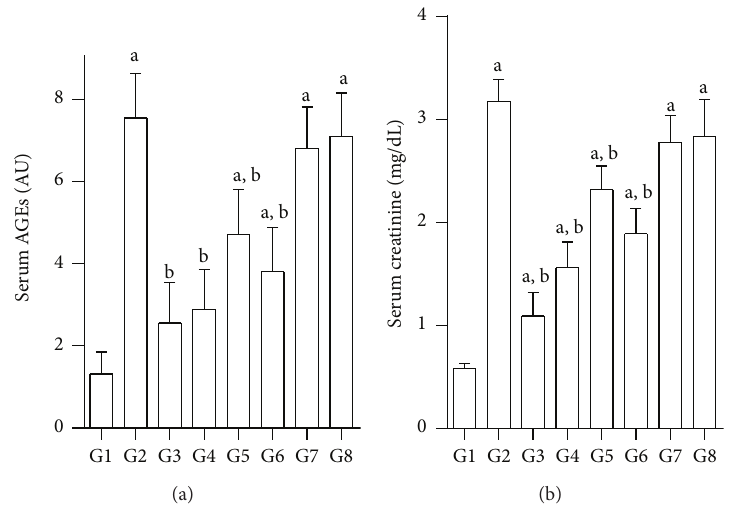
Figure 6: Effect of test compounds on serum AGEs and creatinine in nicotinamide, STZ diabetic rats; (a) serum advanced glycosylation end products (AGEs) measured as arbitrary units (AU); (b) serum creatinine (mg/dL); G1: normal control; G2: diabetic control (nicotinamide + STZ); G3: diabetic + glibenclamide (2.5 mg/kg); G4: diabetic + quercetin (10mg/kg); G5: diabetic + JY-1; G6: diabetic + JY-2; G7: diabetic + JY-3; G8: diabetic + JY-4; (test compounds at optimised dose of 80 mg/kg); a 𝑃 < 0.05 compared to normal rats (G1), b 𝑃 < 0.05 compared to diabetic rats (G2) (one-way ANOVA followed by Tukey’s post-hoc